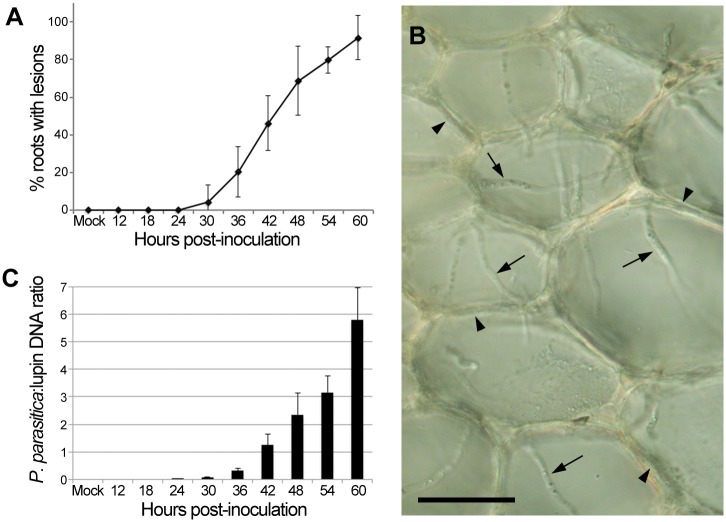
Infection of lupin roots by P. parasitica.
(A) Percentage of roots with visible lesions during the infection time course, 0 hpi to 60 hpi. (n = 12). (B) Transverse hand section of a lupin root inoculated with P. parasitica zoospores. By 27 hpi, P. parasitica hyphae grow both intercellularly (arrowheads) and intracellularly (arrows) during colonisation of the root cortex. Scale bar = 50 μm. (C) Ratio of P. parasitica DNA:lupin DNA as determined by qPCR measurement of the levels of the P. parasitica WS041 gene and the lupin nitrilase gene 4A (NIT4A). Data are from the three biological replicates chosen for RNA-Seq transcriptome analysis. P. parasitica DNA was not detected in mock-inoculated or 12 hpi or 18 hpi samples. Error bars indicate the standard error of the mean.